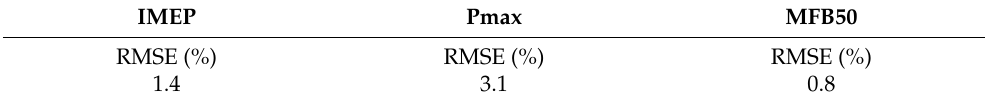
Table 1. Engine model performance on all cylinders for IMEP, Pmax and MFB50; refers to all truck cycle data, with pedals higher than 20% and engine speed higher than 1300